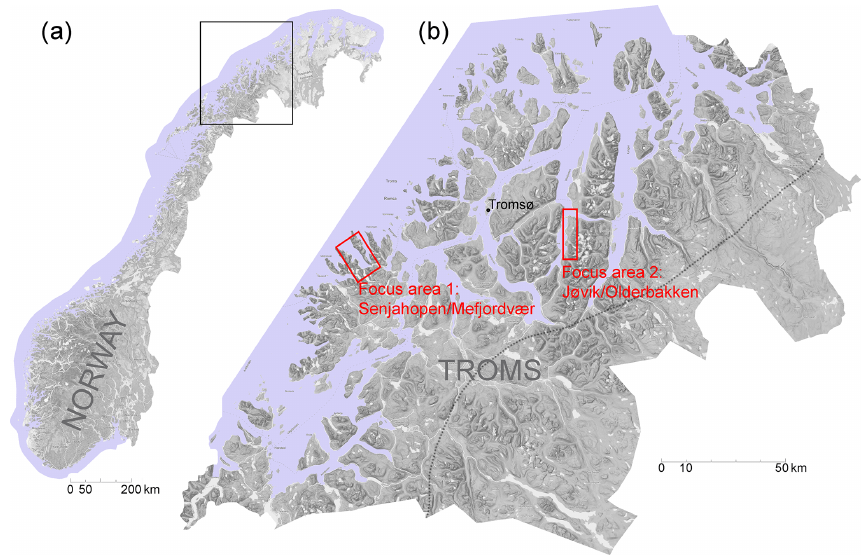
Figure 1. Map of Norway (a) and Troms (b) , with inland and coastal regions separated by the stippled line, and our two focus areas, focus area 1 and focus area 2 in red squares.